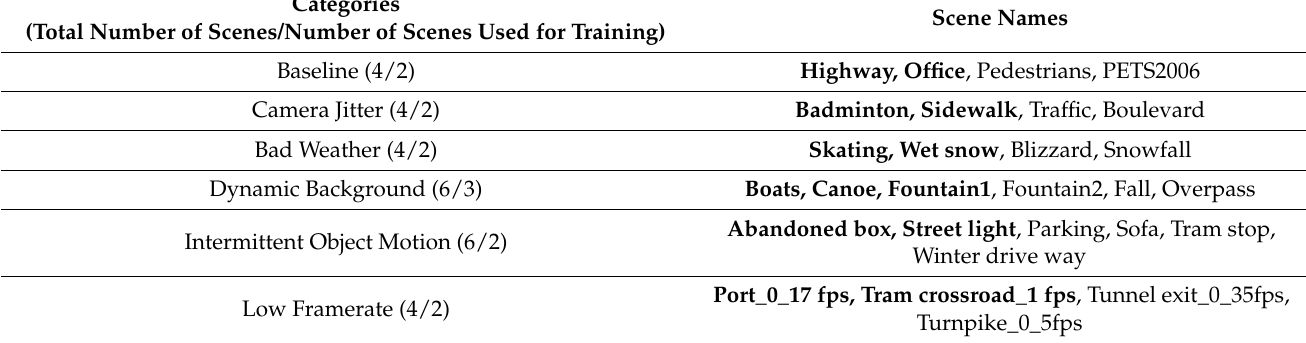
Table 1. List of scenes in the CDnet 2014 dataset (bold indicates the scene used in training).